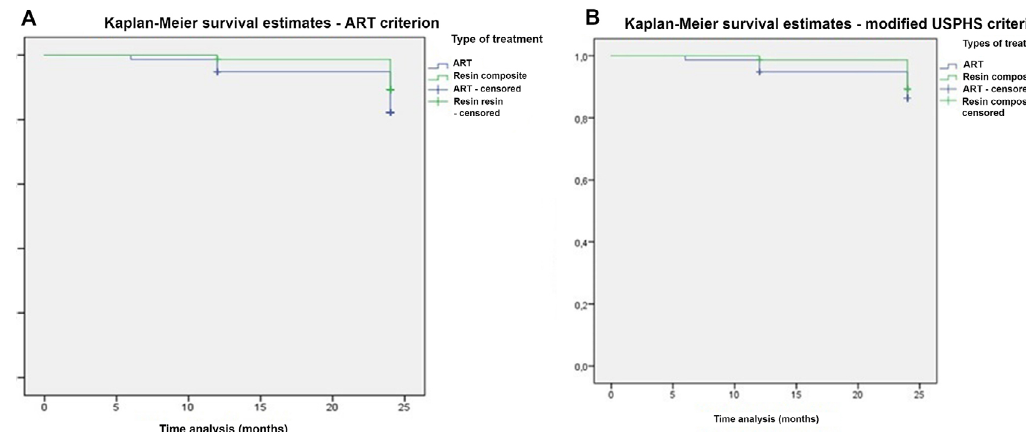
Figure 2- Graphs for survival analysis of ART restorations with HVGIC and conventional restorations with resin composite, at the 2-year follow-up. Graphs represent data assessed with the ART or the modified USPHS criteria